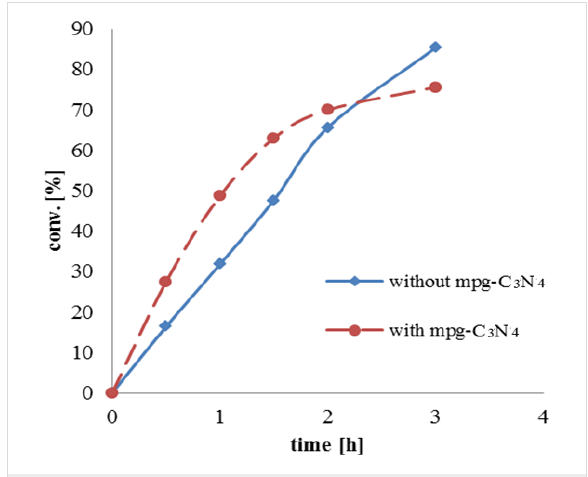
Figure 1: Oxidation of cyclohexanecarbaldehyde to cyclohexane- carboxylic acid under aerobic conditions with and without mpg-C 3 N 4 .